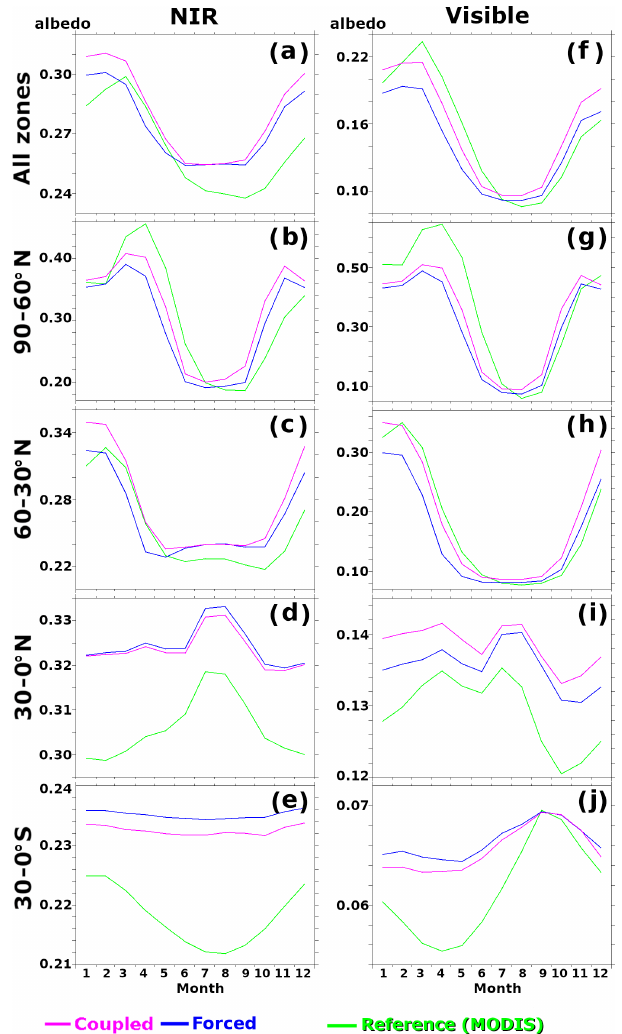
Figure 5. Monthly climatological time series of global and zonal mean albedo. The left column shows the NIR band ( a – global av- erage; b – e – zonal average for each 30 ◦ in latitude), while the right column (f–j) shows the visible band (the vertical arrangement is the same as that for